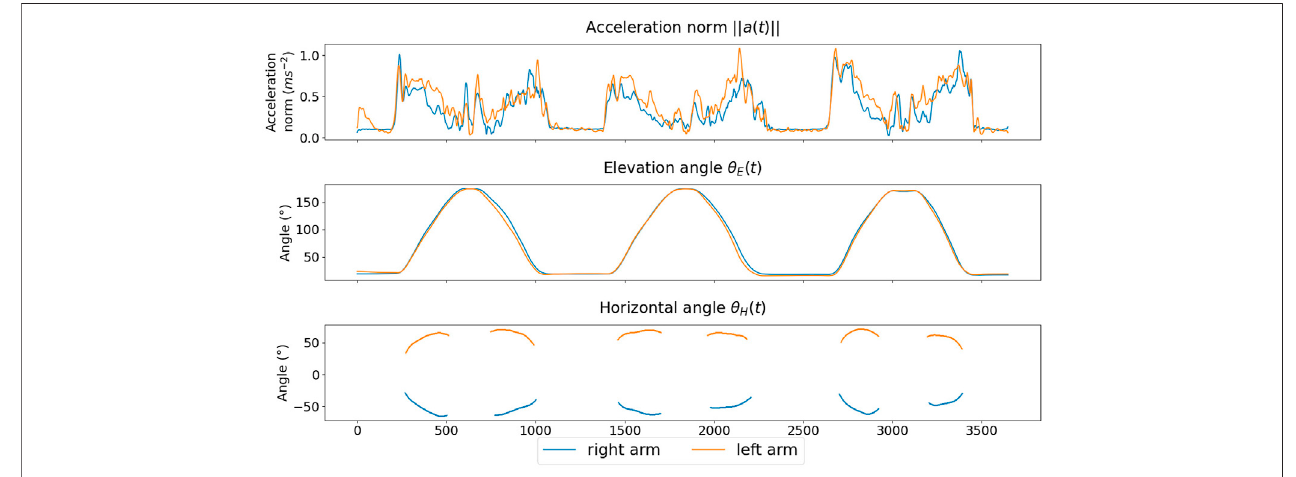
FIGURE 3 | Example of signals for a participant performing scapular plane arm